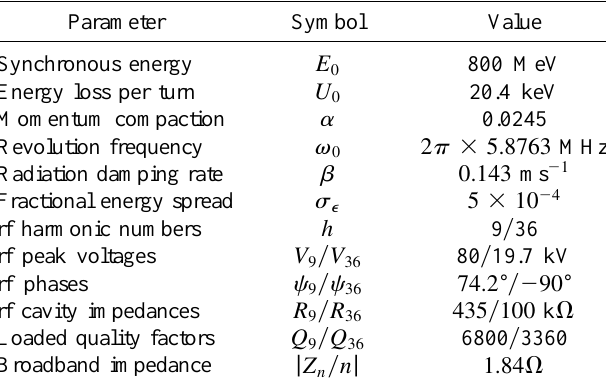
FIG. 1. Simulated beam response functions T 9 55 , T 18 55 , T 36 55 , T 55 55 , and T 135 55 (top to bottom) for a fully stretched 500 mA bunch in the National Synchrotron Light Source (NSLS) vacuum ultraviolet (VUV) ring. Realistically detuned main-cavity and harmonic-cavity impedances are included in the simulation. The vertical scale has an arbitrary scale factor. Machine parameters are given in Table I. TABLE I. Values of VUV ring and main-cavity and harmonic- cavity parameters (separated by a forward slash), symbols, and